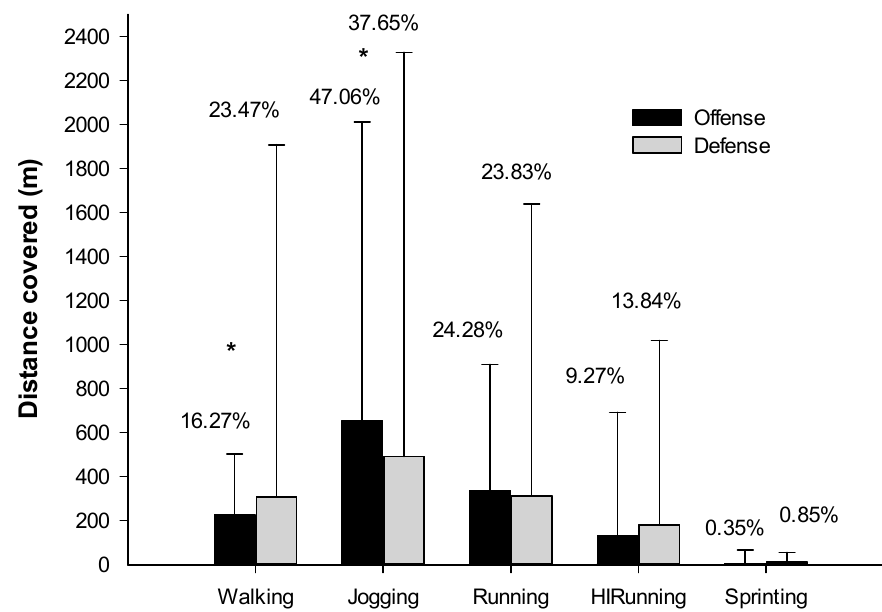
Figure 2. Di ff erences in distance covered in o ff ense and defense during di ff erent locomotion Figure 2. Differences in distance covered in offense and defense during different locomotion characteristics. * Statistical di ff erences; p ≤ 0.05.; HIRunning: High-Intensity running characteristics. * Statistical differences; p ≤ 0.05.; HIRunning: High-Intensity running